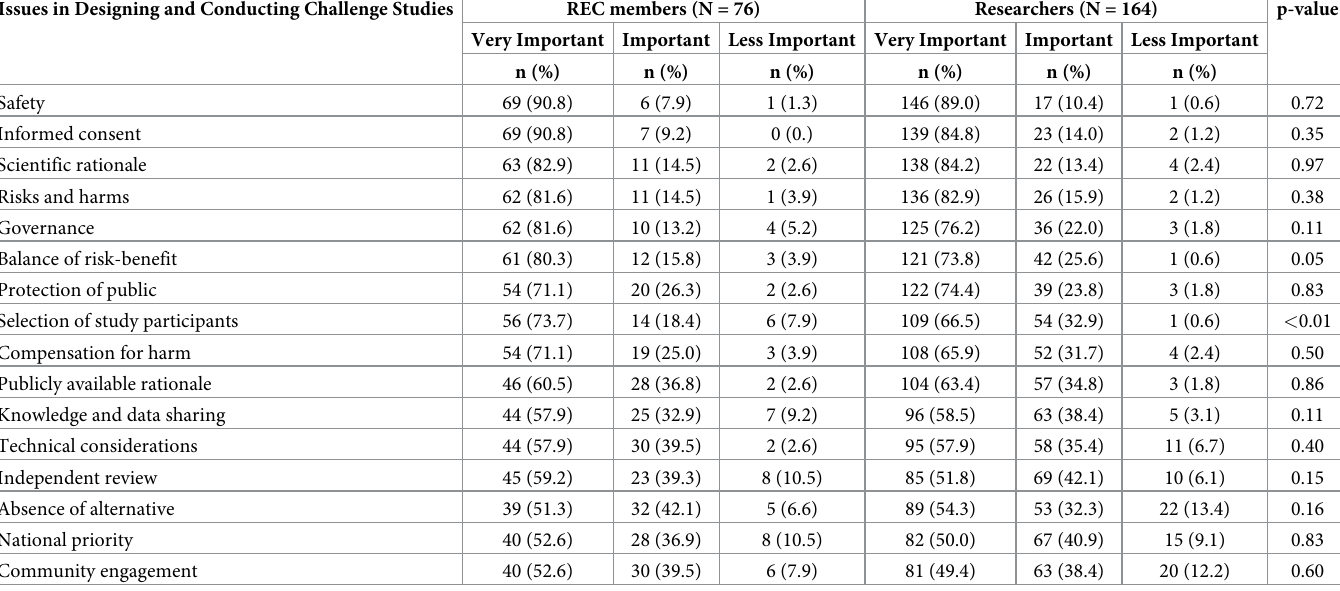
sent process. The level of concern was compared by types of respondents (S1 Table). More clinical sponsorship and intellectual property rights (p-value = 0.01). More researchers with REC Table 4. Comparisons of ratings about challenge studies by researchers and REC